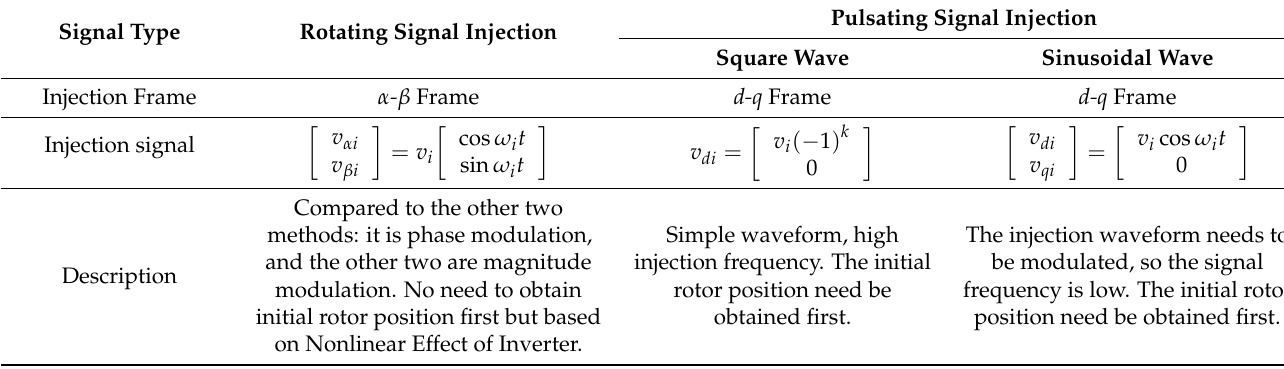
Table 2. Comparison of different HF injection